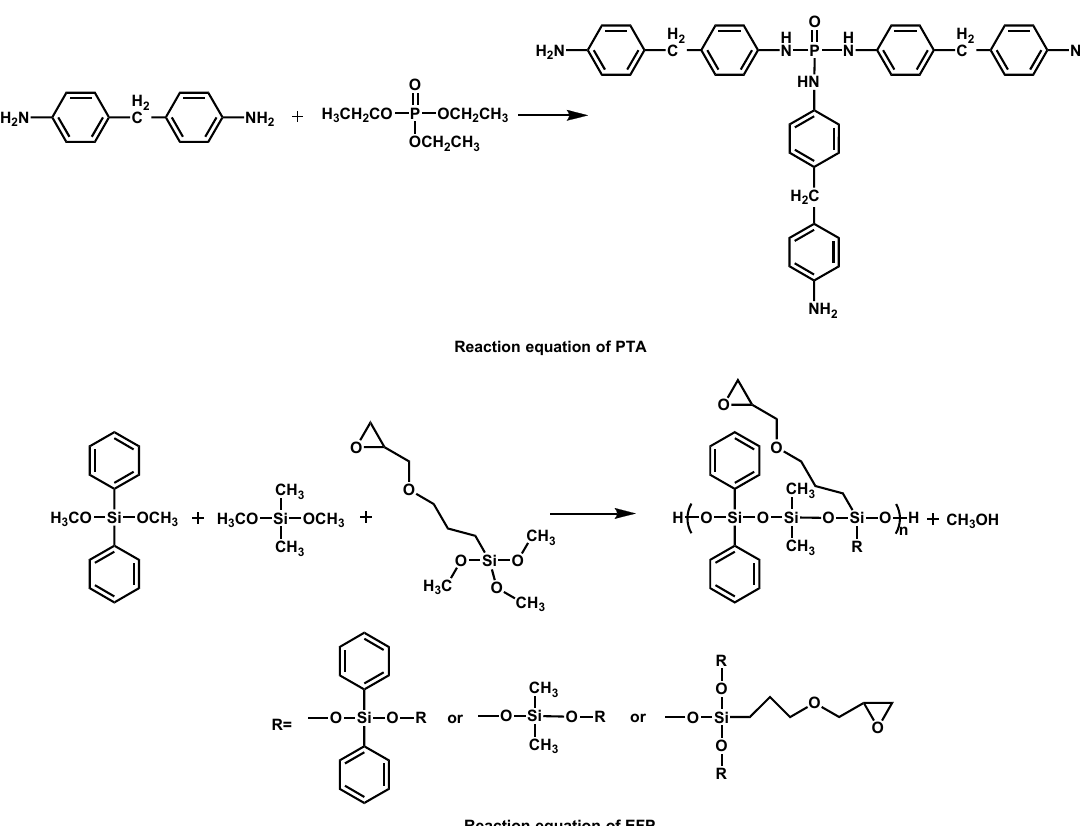
Figure 8. Reaction equation of phosphorous triamide (PTA) and epoxy-functional polysiloxane (EFP). Readapted with permission from Ref. [87], Copyright 2019, Elsevier Ltd. Materials 2020 , 13 , x FOR PEER REVIEW